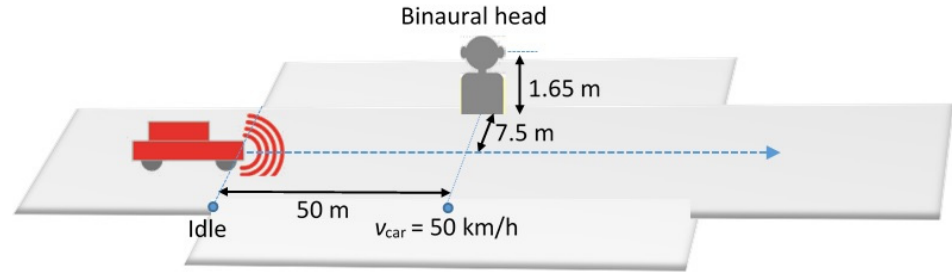
Figure 1. Pass-by traffic situation with measurement position of the binaural head.